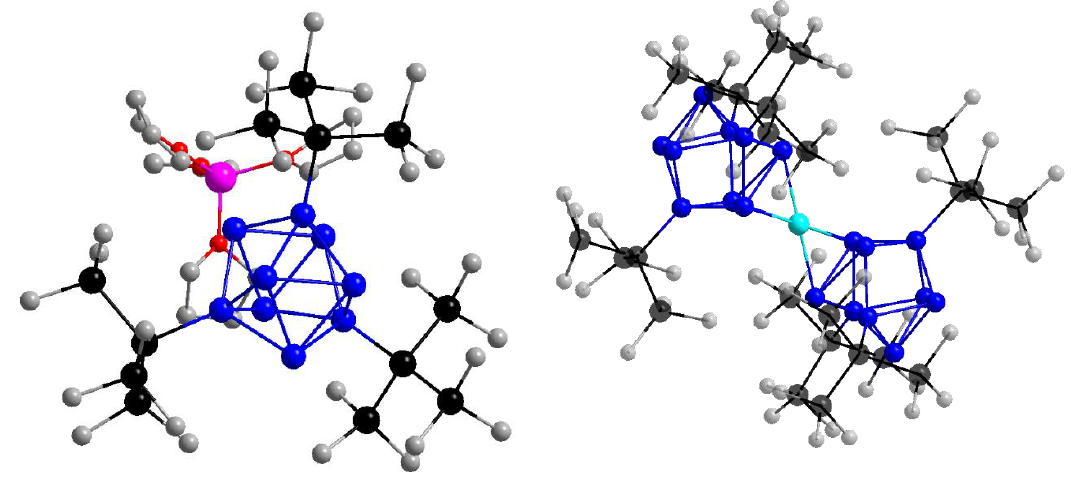
Figure 1. Molecular structure of LiGe 9 (left) and Ge 9 ZnGe 9 (right) from crystallographic data without hydrogen atoms. Color-code: Ge(blue); Zn(cyan); Si(black); C(grey); Li(pink); O(red).